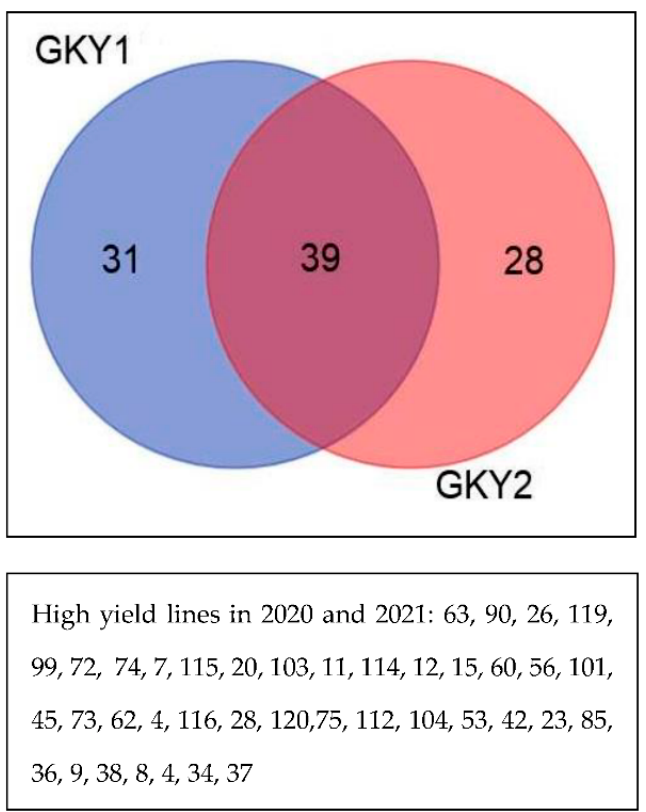
Figure 9. Classification of F8 wheat lines resulting from Gonbad × Kohdasht in 2020 and 2021. The reaction of lines caused by Gonbad × Kohdasht crosses in 2020 showed that lines 106, 103, 103, 60, and 75 were the most important in terms of PH, NDF, TGW, GYI, and NSP. Considering these traits, genotypes 26, 67, 60, and 63 were selected as the best cultivars. The traits of NDF and TGW show the most diversity for the evaluated